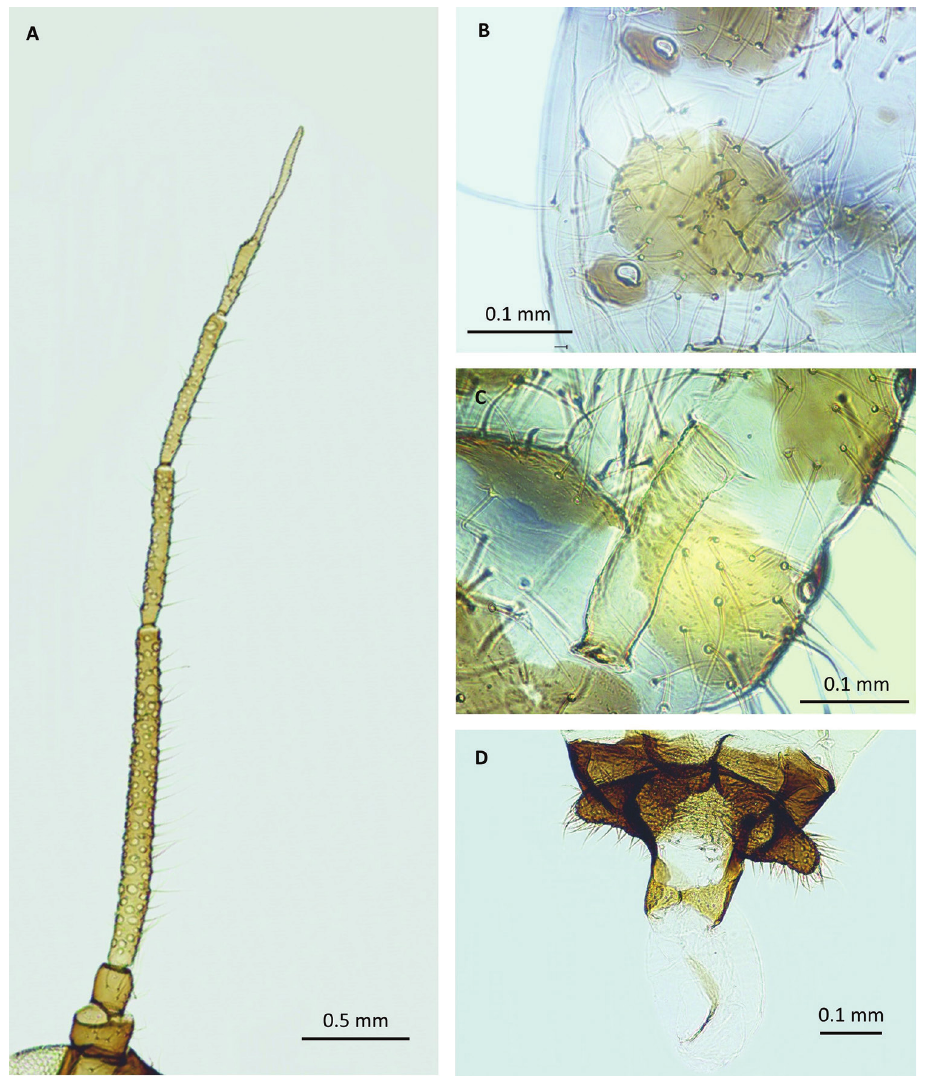
Figure 4. Morphological features of the male: A antenna with multiple secondary rhinaria B marginal plates and stigmal pores C siphunculus D genital apparatus with parameres and membranous segments, with spiracles in the anterior margins of the sclerites and with conspicuous marginal tubercles (Fig. 4B), dark pigmented, on segments I-IV and VI-VII, occasion- ally also on V. Siphunculi pale, 0.19–0.22 mm long, 0.30–0.32 of antennal segment III, tapering, with weakly swollen apical part and small flange (Fig. 4C). Cauda small, pigmented, semicircular, sparsely covered with hairs. Genital apparatus sclerotized, parmeres conspicuous, dark, densely covered by relatively short hairs; base of the mem- branous aedeagus less sclerotized, sparsely covered by very short hairs (Fig. 4D).